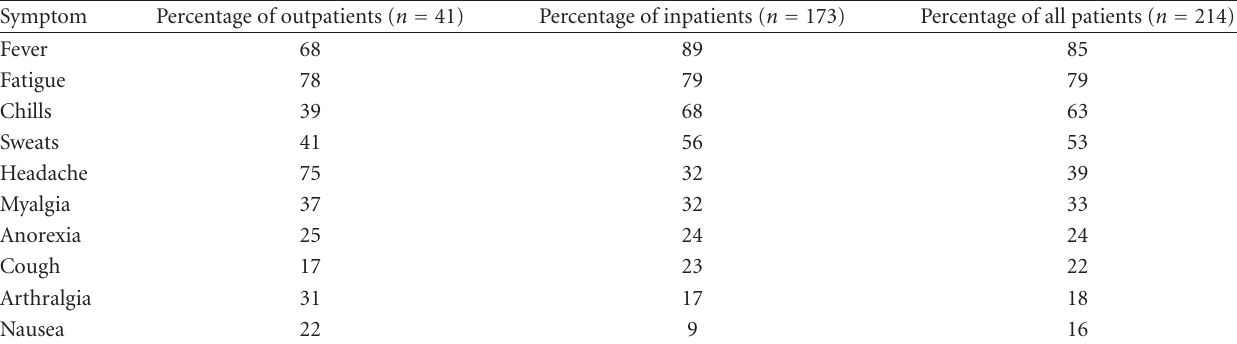
Table 1: The most common symptoms of babesiosis caused by Babesia microti infection.